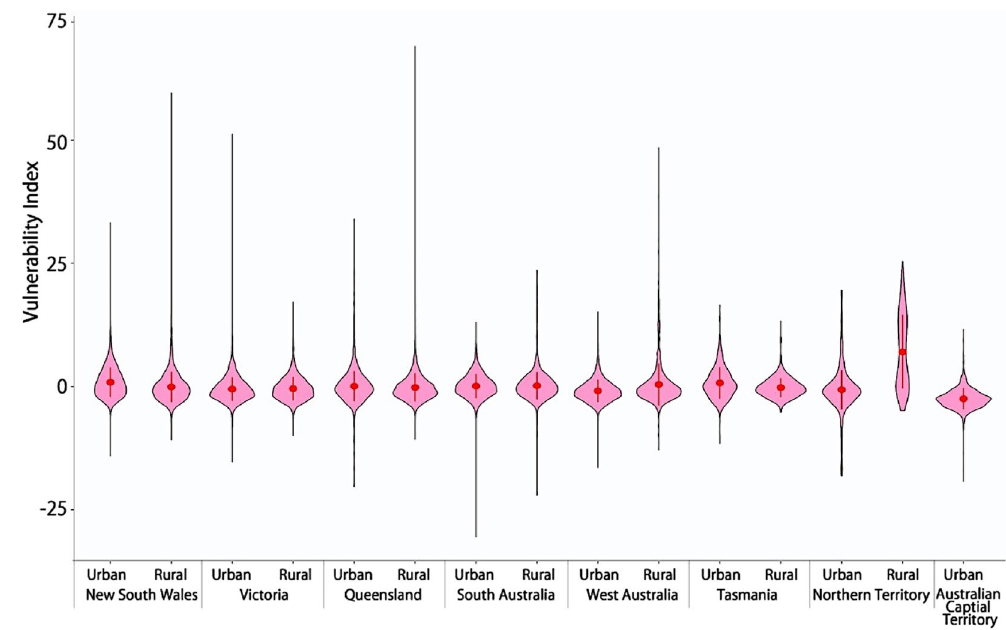
Figure 5. Violin plots showing the statistical distribution of the vulnerability index in urban and rural areas. Statistical details are provided in Supplementary Table S8. The vertical black line indicates the range (maximum and minimum) of the vulnerability index. The width of water-drop pink areas indicates the density distribution of the vulnerability index; a wider width means more spatial units (SA1s) concentrate in that vulnerability index. The red dot indicates the mean of the vulnerability index and the vertical red line represents 95% confidence intervals. X axis presents the ACT as urban space together with seven states which were divided into urban and rural space. The ranges of the vulnerability index across are substantially different urban and rural space. In Victoria and Tasmania, the vulnerability index in urban areas (e.g., Melbourne: − 15.260 to 51.240) have wider ranges than that in its rural areas; while in other states (e.g., New South Wales, Queensland, and West Australia), the vulnerability index in urban areas (e.g., Sydney: − 14.038 to 33.238), have wider ranges than the vulnerability index in rural areas (Supplementary Table